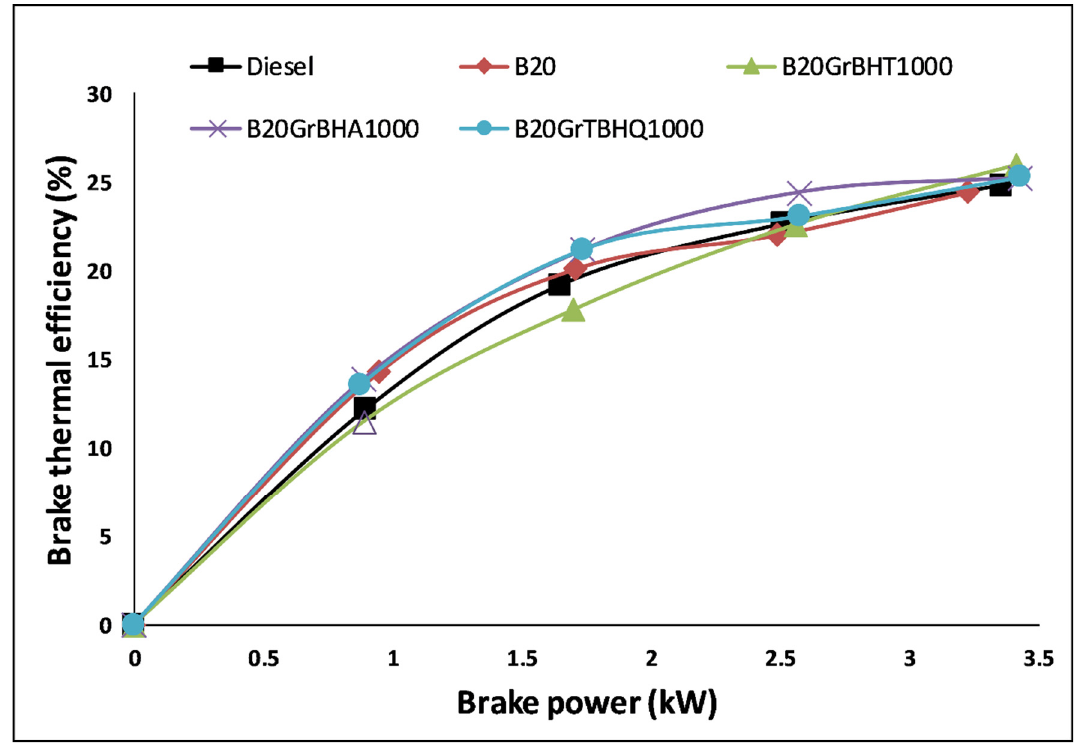
Figure 3. Deviation of brake thermal efficiency with brake power .